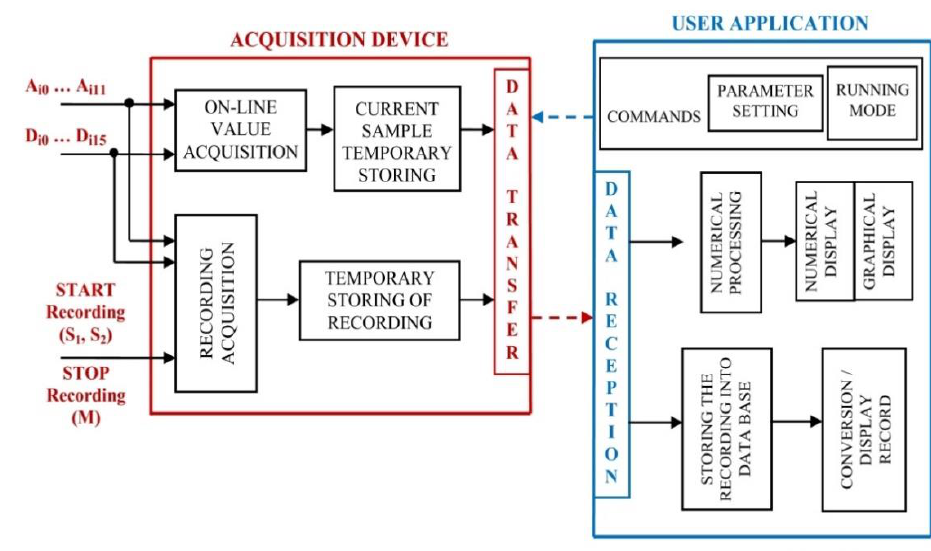
Figure 3. High-level/low-level interaction flow.